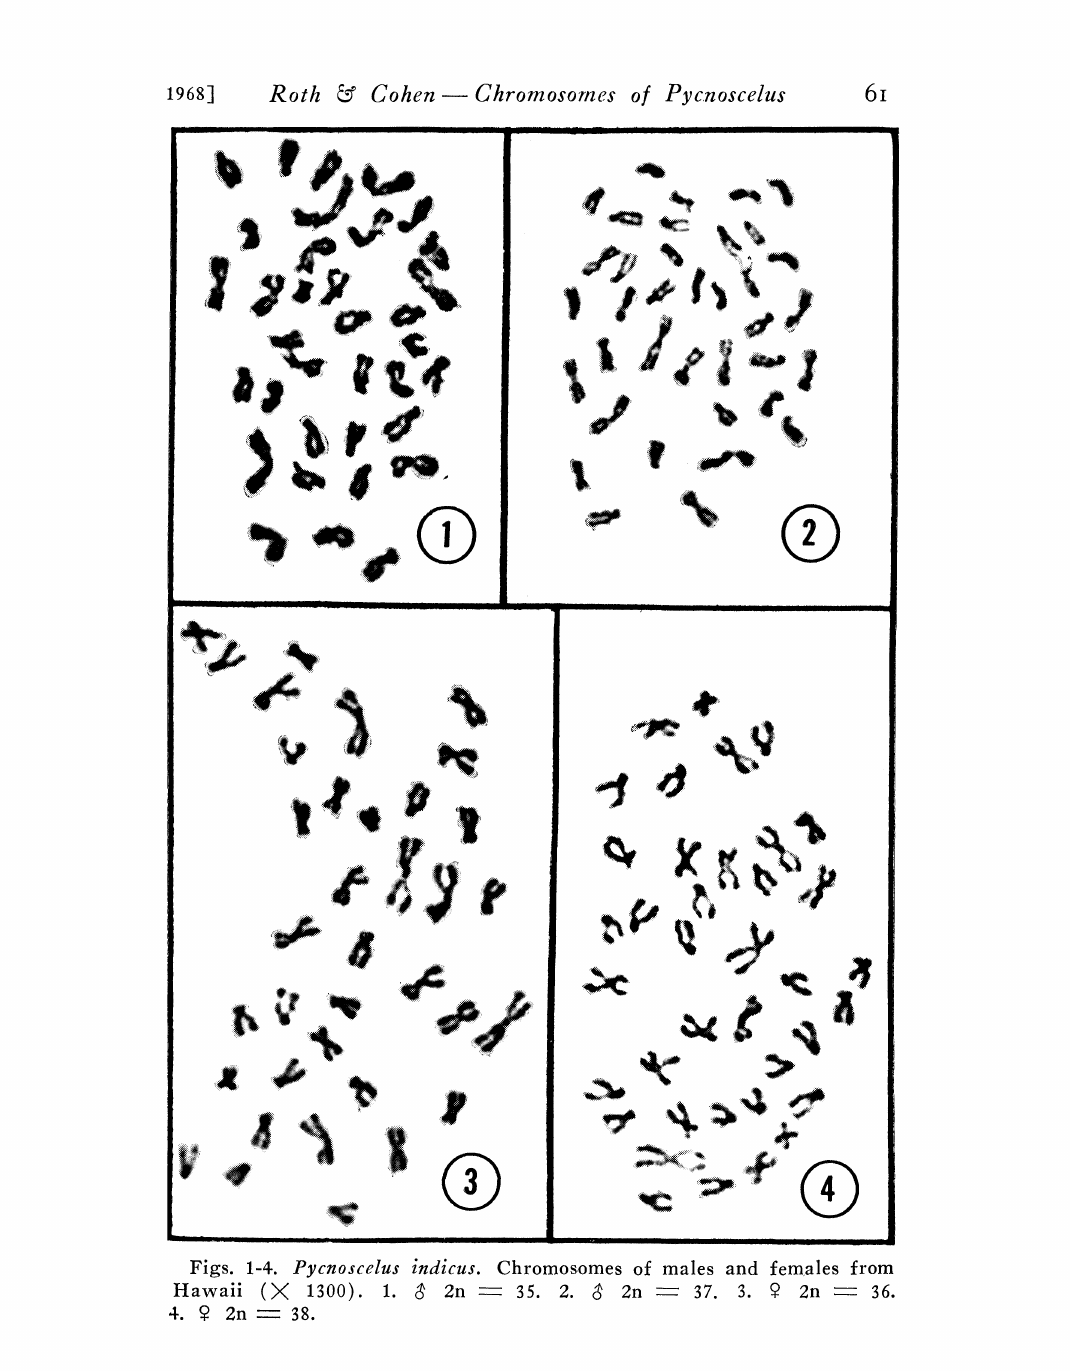
Figs. 1-4. Pycnoscelus indicus. Chromosomes of males and females from Hawaii (X 1300).